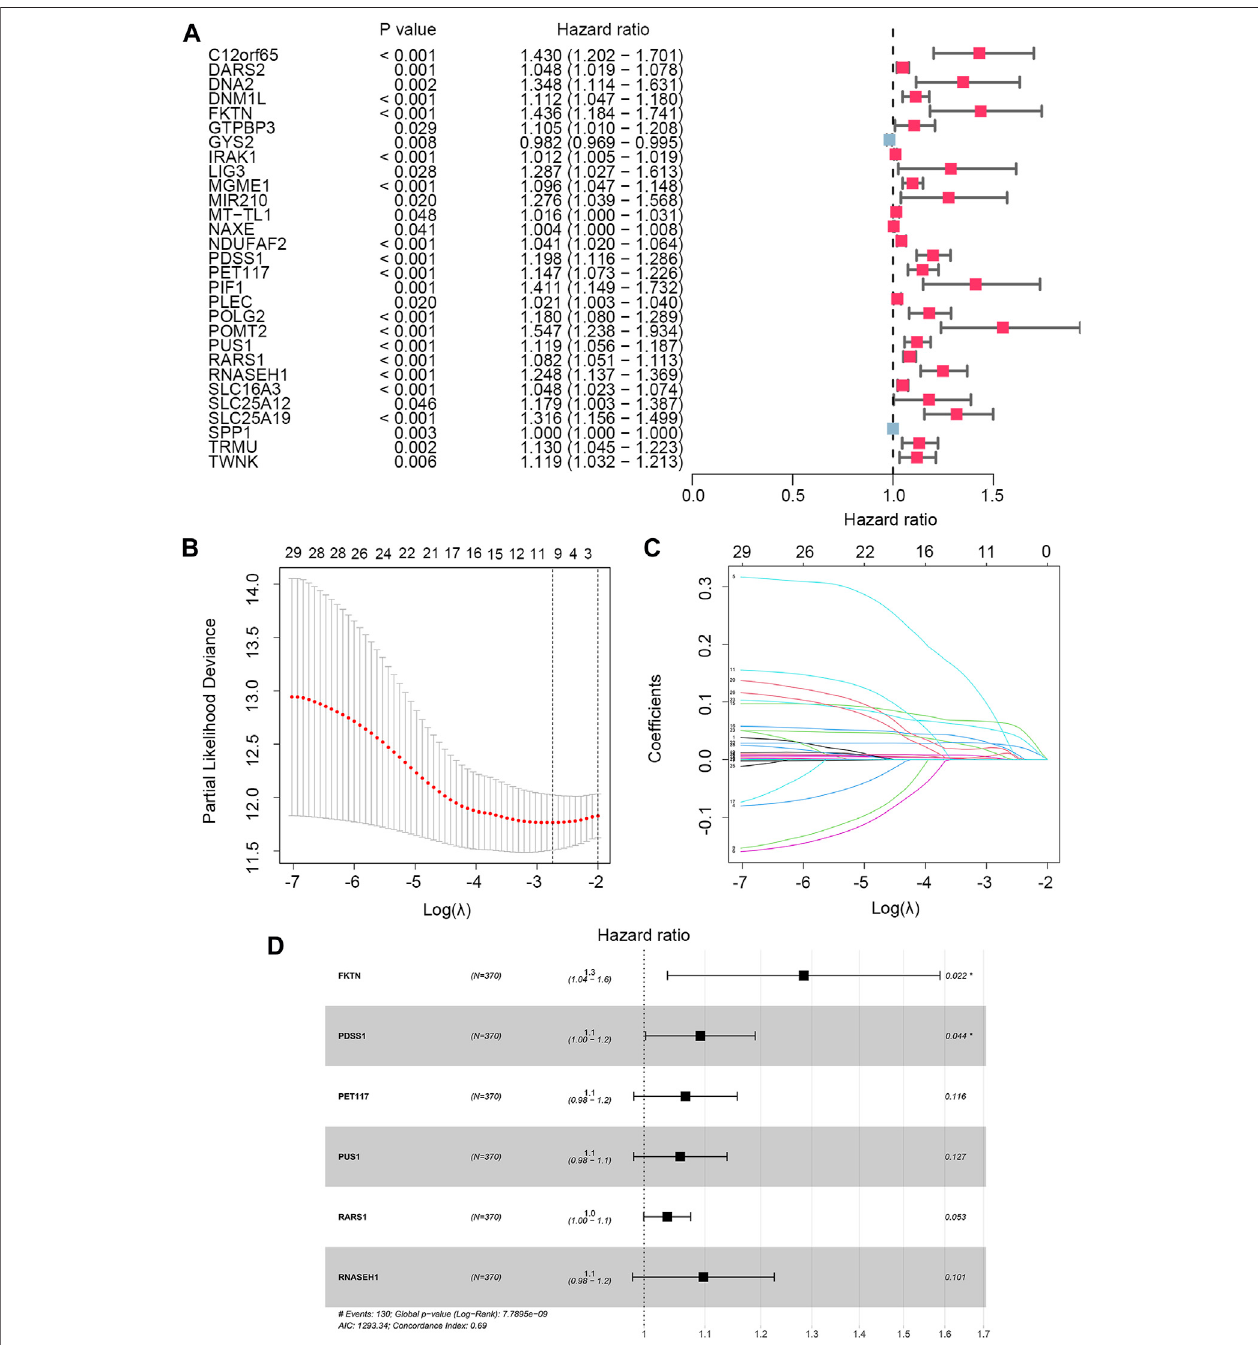
FIGURE2| Coxregressionanalysisand LASSOanalysisofLMRGs. (A) UnivariateCoxregressionanalysisscreened29prognosticLMRGs. (B) Tuningparameter ( λ ) selection in LASSO model using cross-validation. (C) The LASSO coef fi cient pro fi le of 29 prognostic LMRGs. (D) Multivariate Cox regression analysis of LMRGs was shown by forest